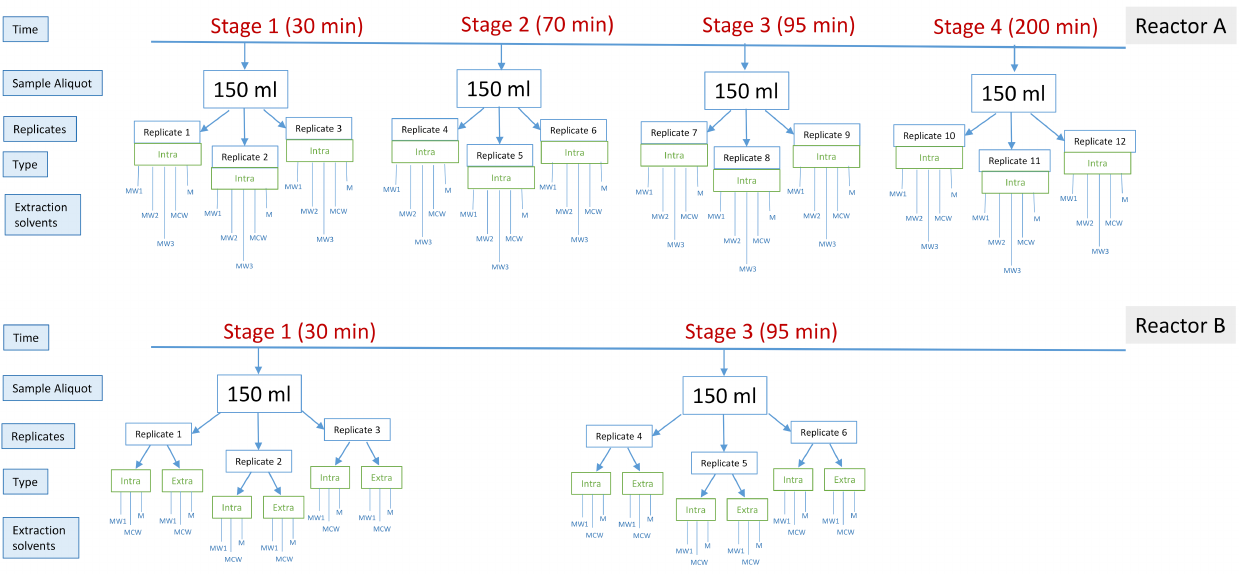
Figure 1. Schematic diagram of experimental design for (upper panel) Reactor A and (lower panel) Reactor